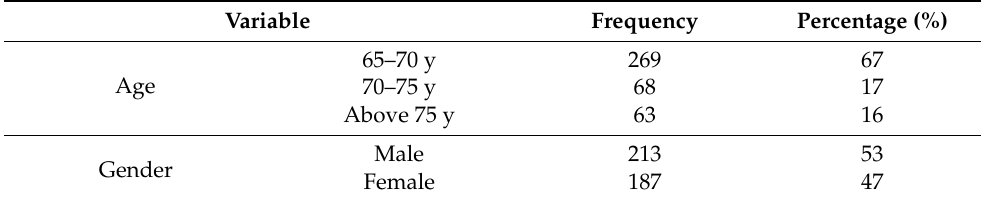
Table 1. The distribution of the sample according to demographical and economic factors such as age, gender, educational level, and working